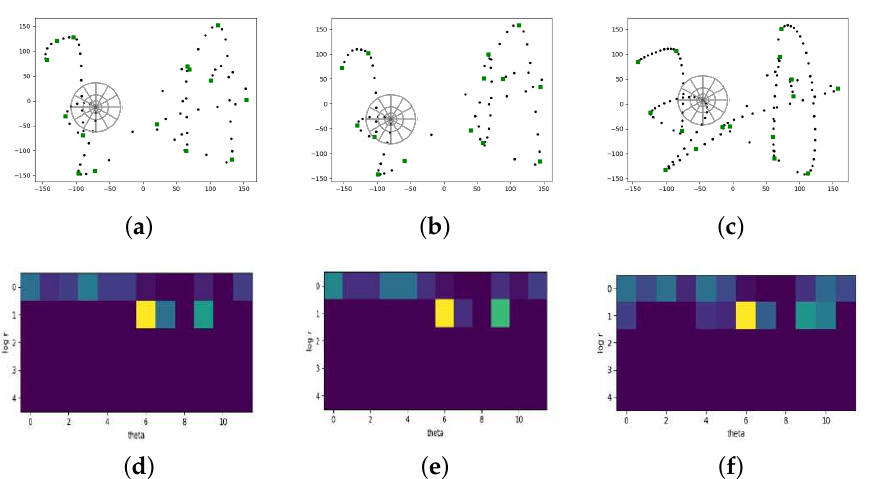
Figure 3. Examples of shape context feature extraction. ( a ) A reference signature of one user. ( b ) A corresponding genuine signature from the same user with reference one. ( c ) A skilled corresponding forgery from the same user with reference one. The green square points represent selected trend-transition-points. ( d – f ) Shape context histograms for chosen trend-transition-point in the signatures of ( a – c ),